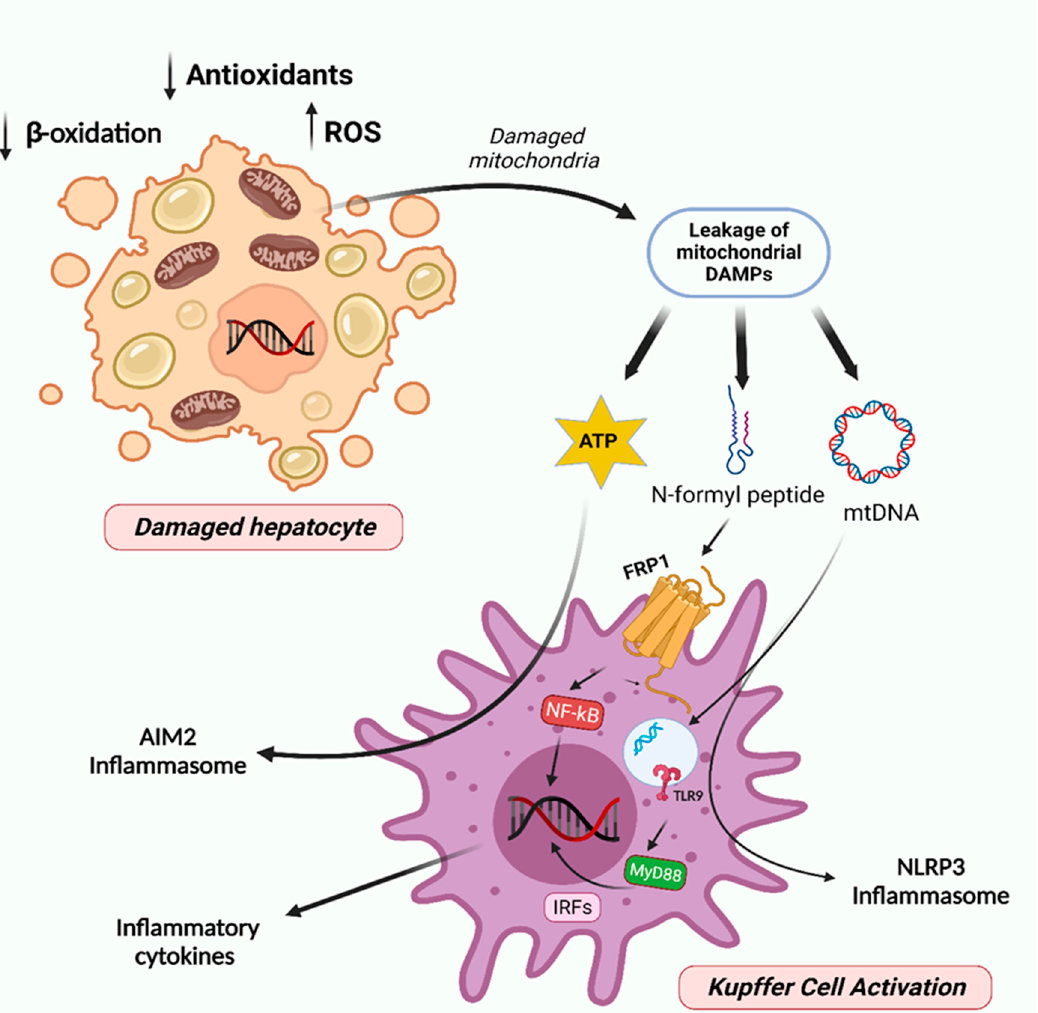
Figure 4. Mitochondria involvement in NAFL progression to steatohepatitis and fibrosis . The augmented accumulation of damaged/dysfunctional mitochondria within hepatocytes results in cell necrosis and induces the leakage of mitochondrial DAMPs, such as mtDNA, N-formyl peptides, and ATP. Further, these signals trigger the activation of toll-like receptor 9 (TLR9) and formyl peptide receptor 1 (FPR1), which in turn activates the IRFs and NF-kB and thereby the production of inflammatory cytokines. mtDNA and ATP also activate the inflammasomes NLRP3 and AIM2, respectively. Multiple inflammatory cytokines and the activation of inflammasomes provide a chronic inflammatory milieu, which contributes to the development of steatohepatitis and fibrosis. Created with BioRender.com (accessed on 5 February